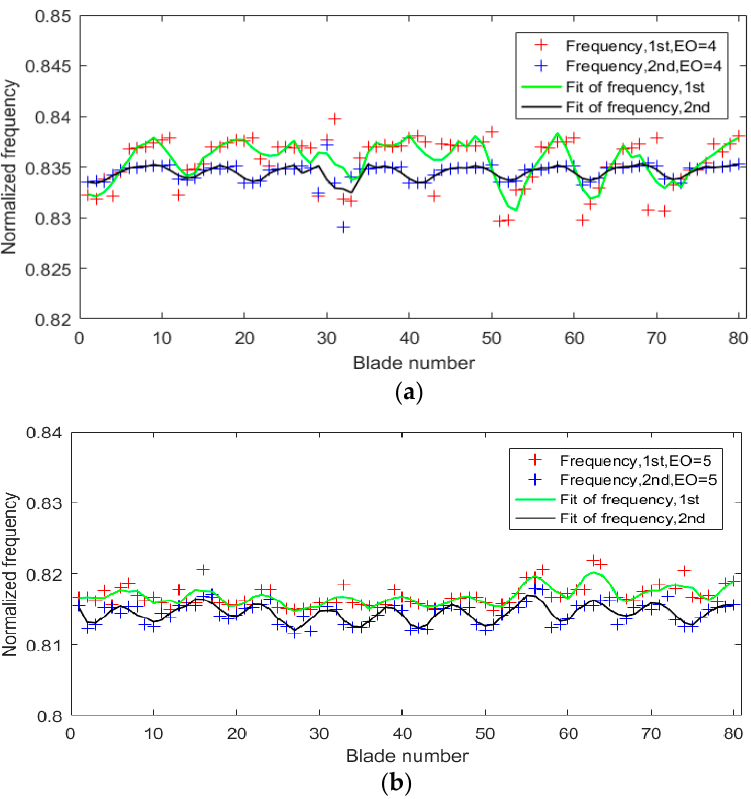
Figure 14. Comparison of normalized frequencies: ( a ) EO = 4 and ( b ) EO = 5.